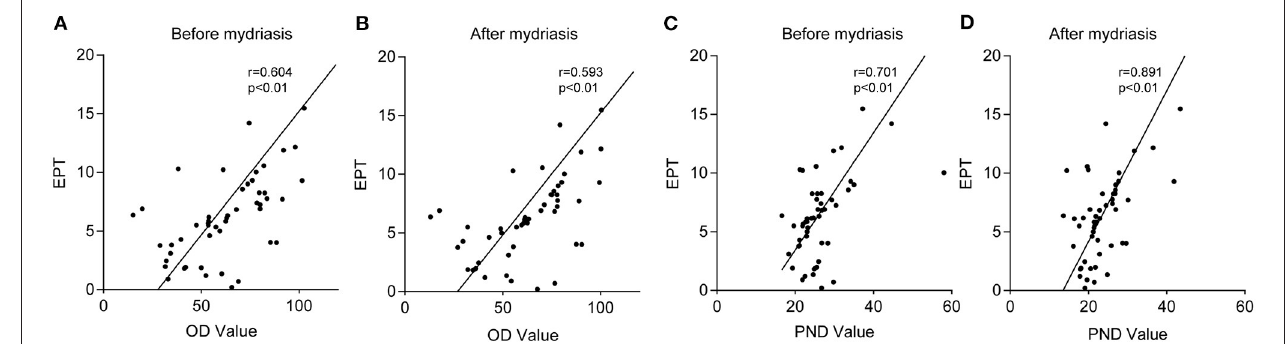
FIGURE 4 | The correlations between the OD value and effective phacoemulsification time (EPT) value and the PND value and EPT value. Graphs (A,B) showing the correlation between the OD value and EPT value before and after mydriasis. Graph (C,D) showing the correlation between the PND value and EPT value before and after mydriasis. There was a positive correlation between the OD value and EPT value ( r = 0.604 and r = 0.593, respectively, both p < 0.01) and between the PND value and EPT value ( r = 0.701 and r = 0.891, respectively, both p < 0.01) before and after